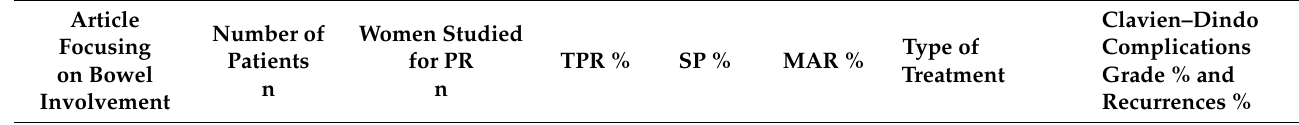
Table 3. Studies on PR, postoperative complications, and recurrences after colorectal surgery for deep